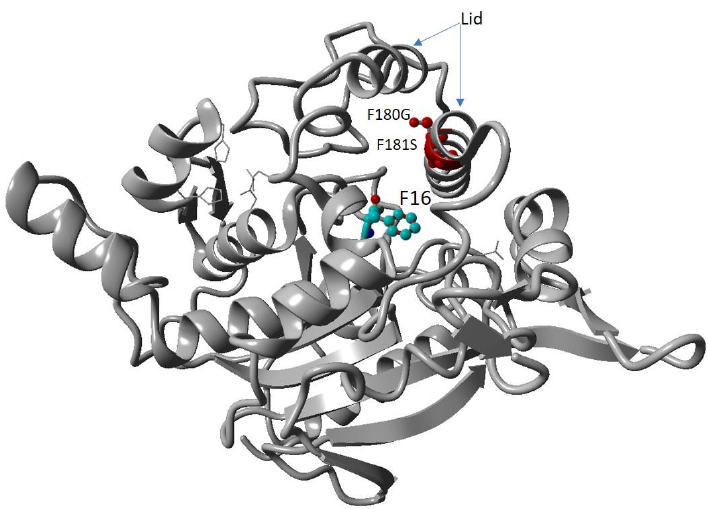
Figure 1. Modelled mutant lipase with highlighted mutated residues. Red coloured residues are the mutations of F180G and F181S. The oxyanion hole residue F16 is the coloured element.